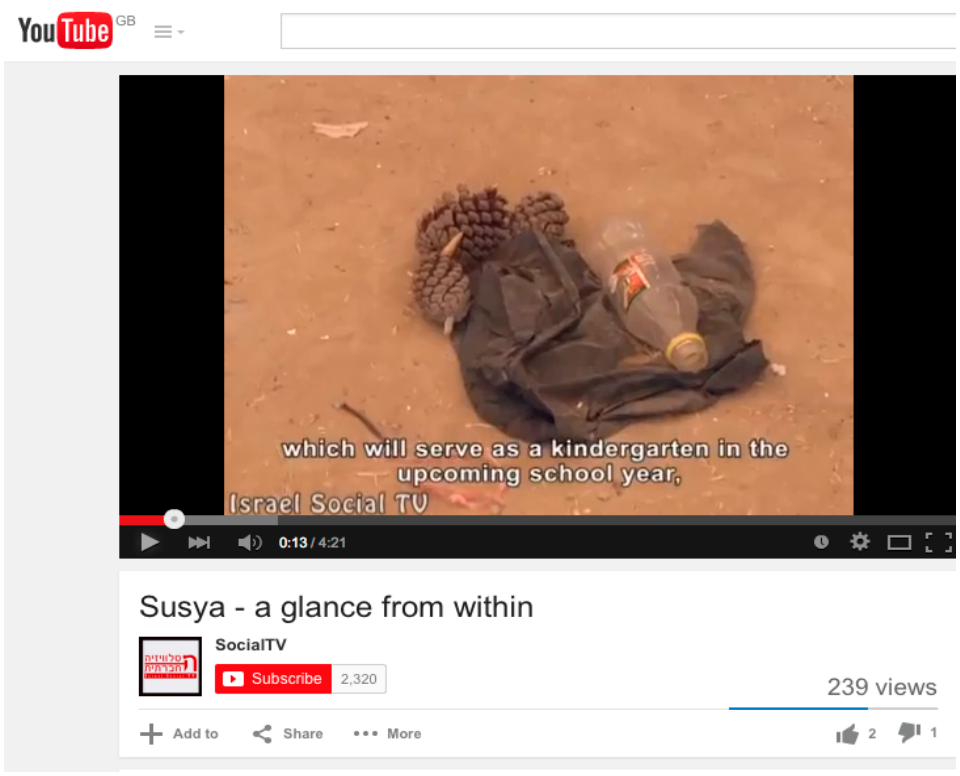
Figure 13. Screen grab from Social TV’s feature on Susiya—‘A Glance from Within’.